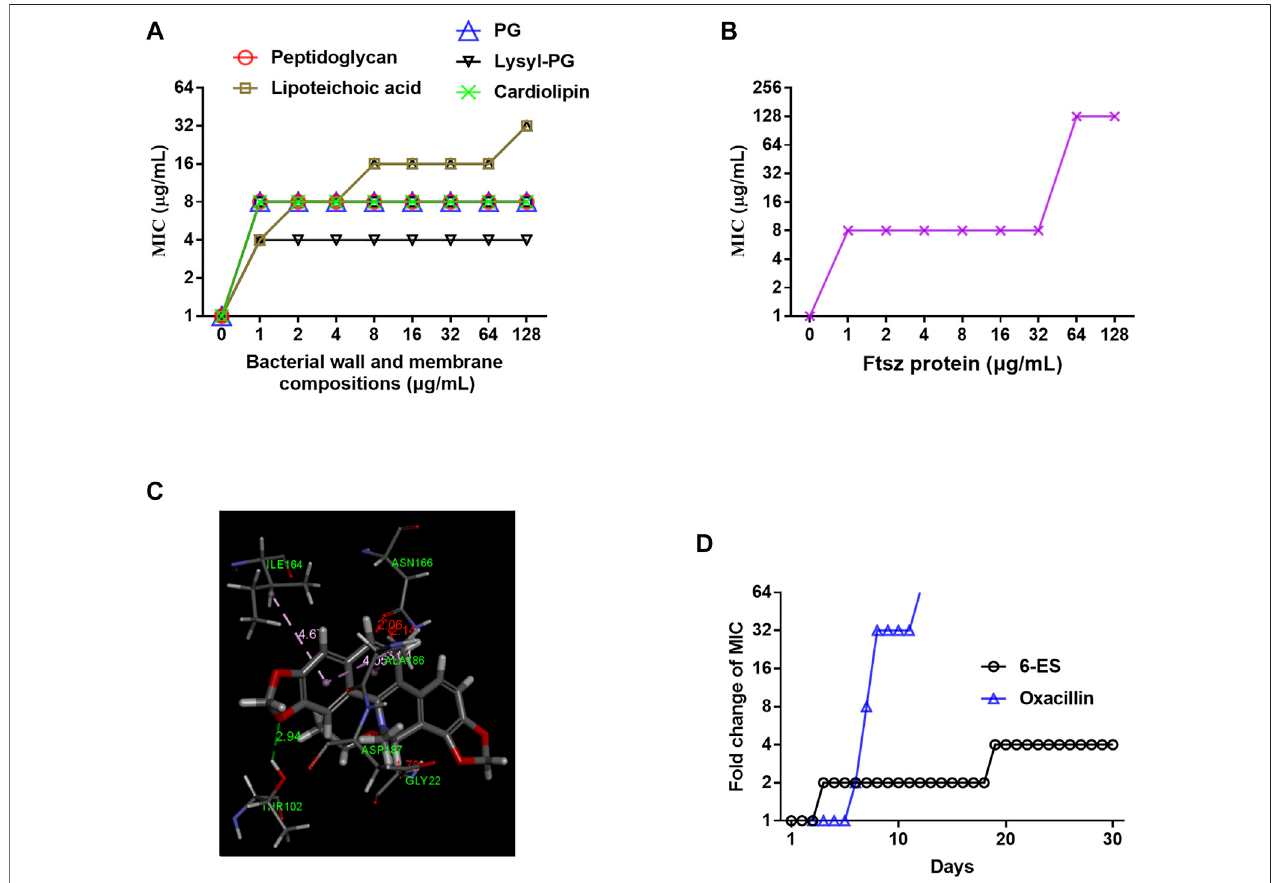
FIGURE3| 6-EthoxysanguinarineinhibitedbacterialgrowthpossiblybytargetingthebacterialwallandmembraneandFtsZ. (A,B) TheMICof6-ESagainstMRSA T144in thepresence ofcell wallcomponents,membranephospholipids,and FtsZ. (C) Molecular docking of6-ESwithFtsZ. (D) 6-ESdisplayed alowlevelofresistance development. S. aureus ATCC29213 was continuously incubated with sub-MIC levels of 6-ES for 30 days. The sensitivity of bacteria to 6-ES was recorded.